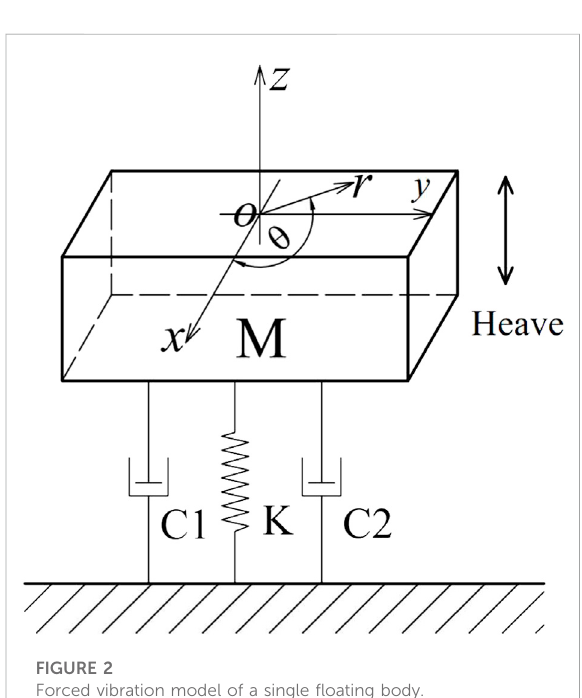
FIGURE 2 Forced vibration model of a single fl oating